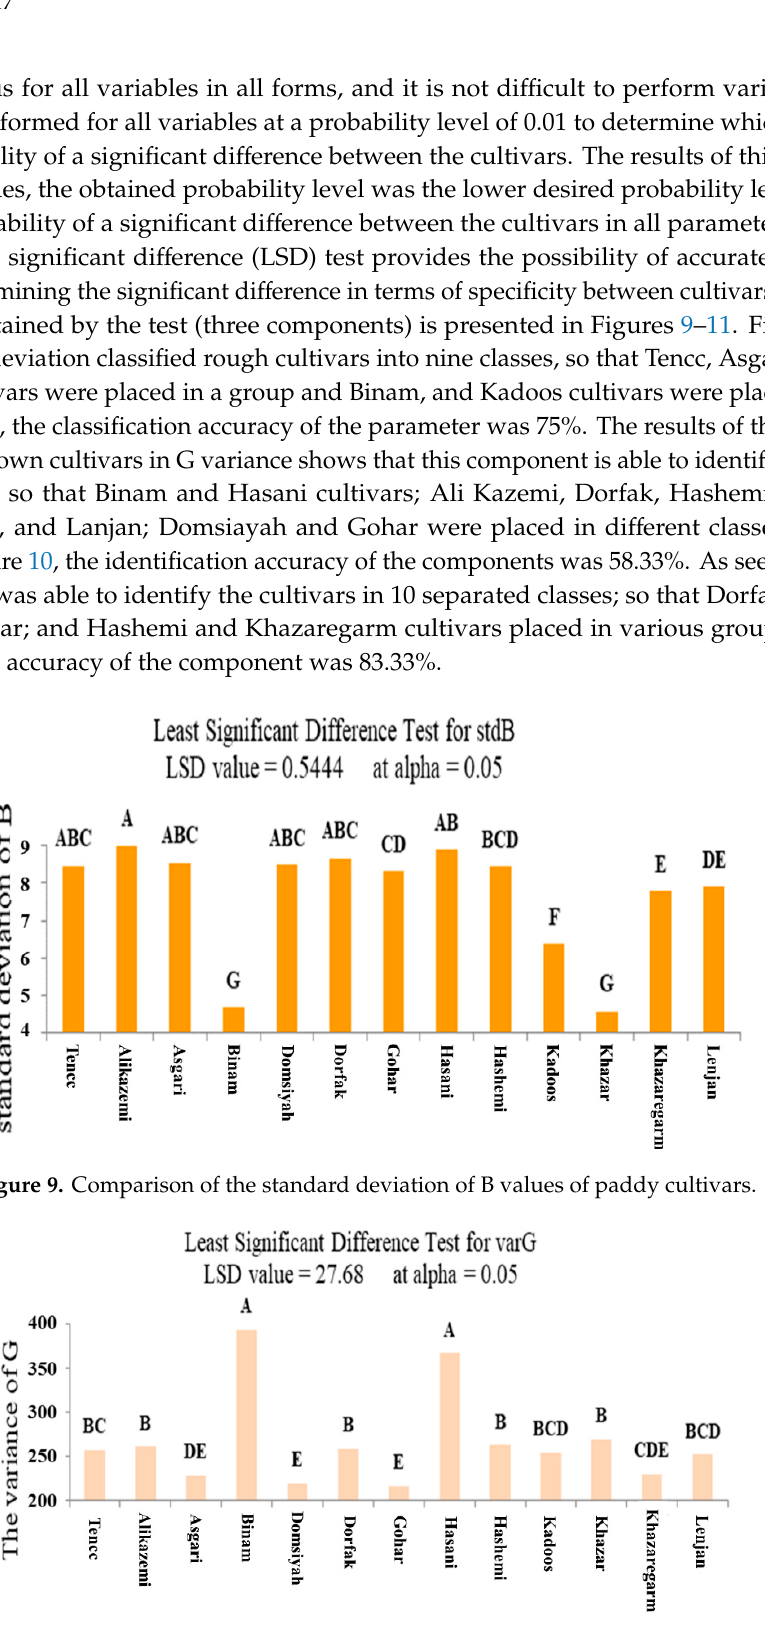
Figure 10. Test results of the least significant di ff erence (LSD) for the variance values of G in brown rice